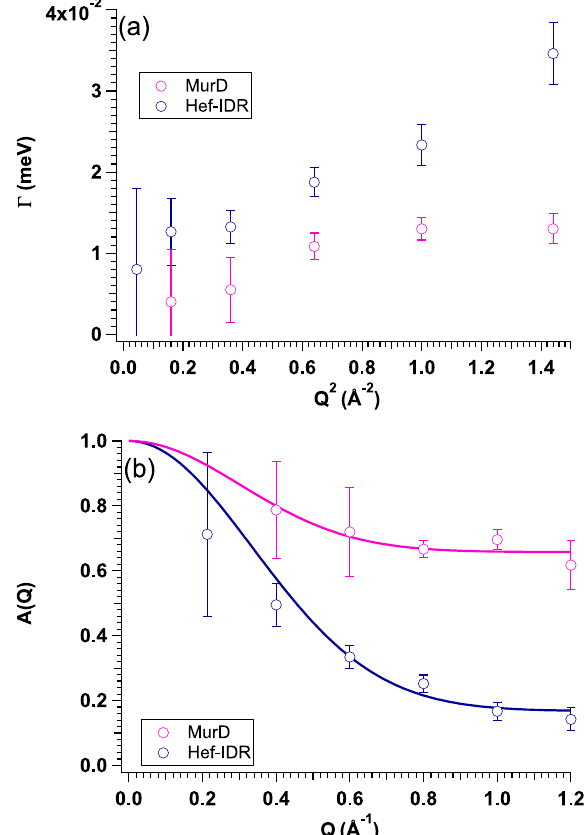
Figure 3. Q 2 dependences of Γ values and A ( Q )s. (a) Q 2 dependences of Γ values of MurD (pink circle) and Hef-IDR (blue circle), respectively. (b) Q 2 dependences of A ( Q )s of MurD (pink circle) and Hef-IDR (blue circle), respectively. Solid lines correspond to the fits with Eq. (6) for MurD (pink line) and Hef-IDR (blue line), respectively. This figure is prepared by the usage of IGOR Pro 6.34A (https ://www.wavem etric s.com/forum / news-and-annou nceme nts/igor-634a-now-shipp